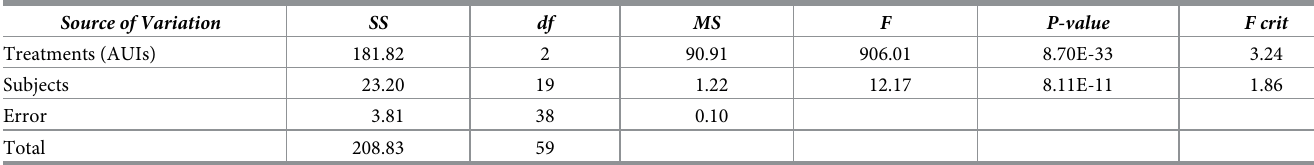
Table 4. Repeated-measures ANOVA—Group #1.